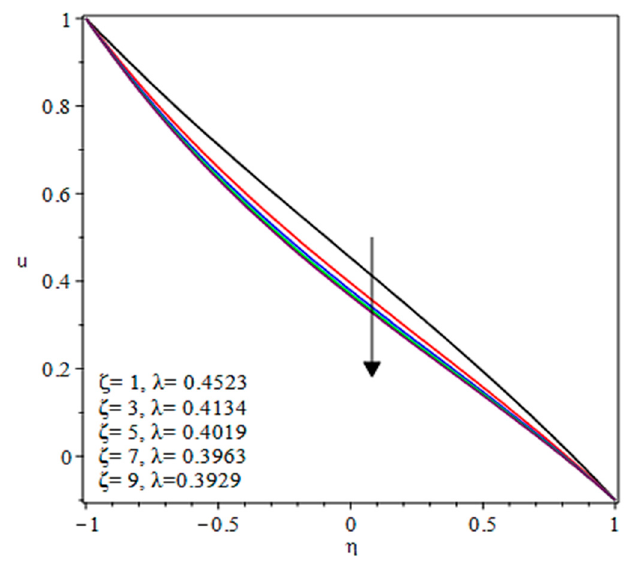
Figure 8. Viscoplastic parameter ζ influence on the velocity profile at ξ = 0 by fixing K = 0.1, M = 1.